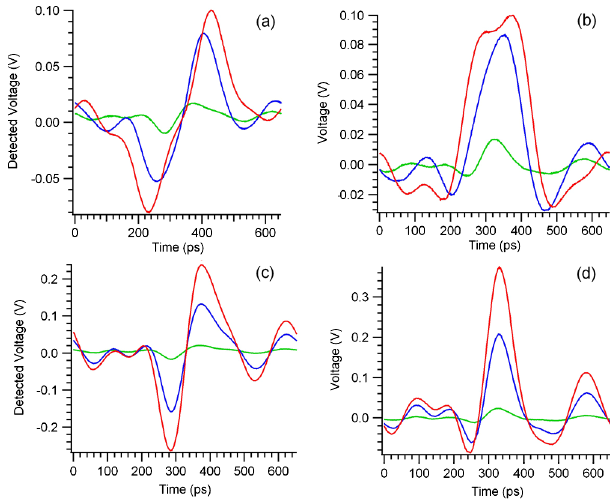
FIG. 7. Comparison of bunches from thick GaAs (blue traces) and thin strained-layer superlattice GaAs/GaAsP photocathodes (red traces) at 175 kV bias voltage and at three currents: (a) 25 (cid:1) A , (b) 250 (cid:1) A , and (c) 500 (cid:1) A